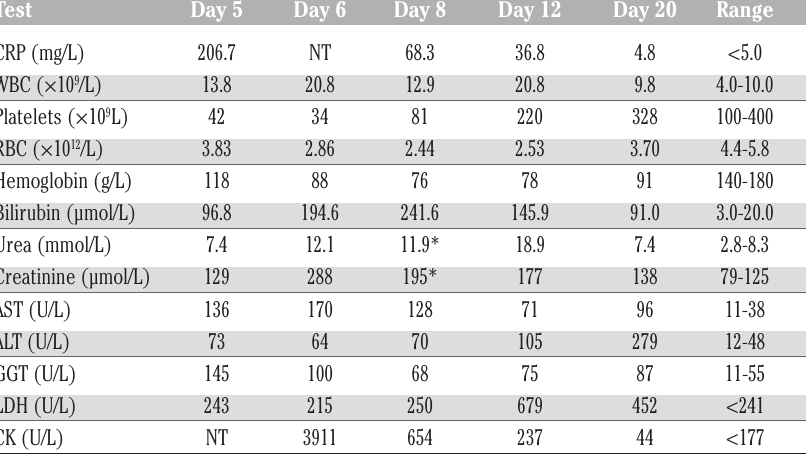
Table 2. Results of the microscopic aggluti- nation test for leptospira. Serovar Antibody titre* Grippotyphosa 1000 Sejrö Negative Australis Negative Pomona Negative Canicola 4000 Icterohaemorrhagiae Negative Tarassovi 2000 Saxköbing Negative Ballum Negative Bataviae Negative Poi Negative Hardjo Negative Autumnalis Negative Mitis Negative Patoc